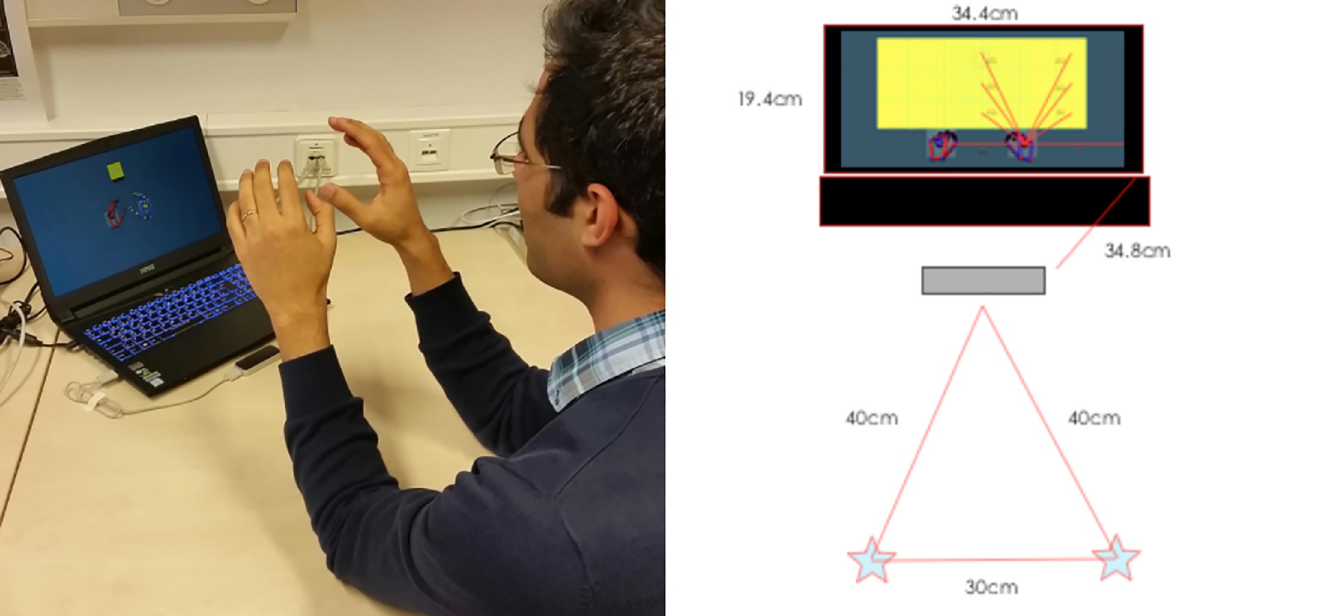
Fig 2. Experimental setup. The left panel shows a participant in the “initial starting position” before going to contact the cube. The right panel shows the same setup in a schematic drawing with the distances on the setup. Respectively, the stars are where the elbows were placed, the grey rectangle is the Leap Motion, and the black rectangles are the keyboard and computer